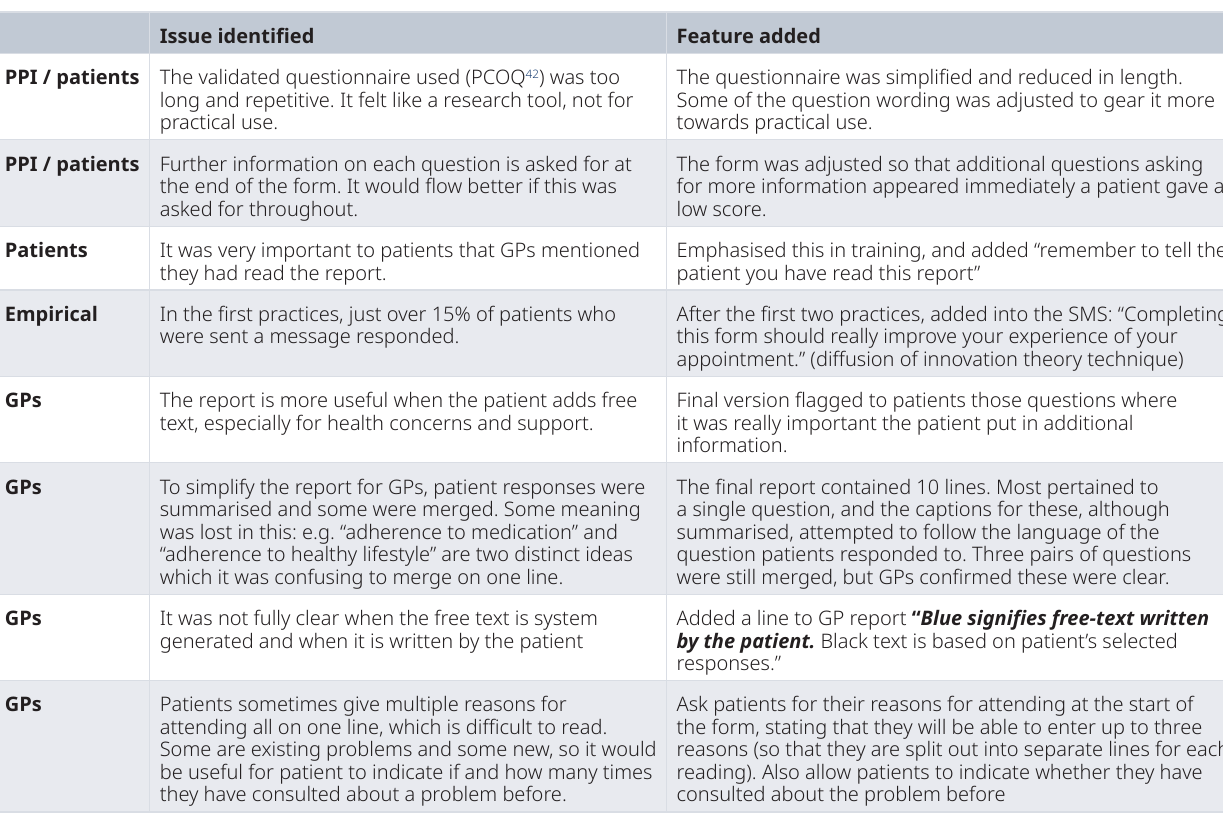
Table 5. Summary of changes: pre-consultation form. Issue